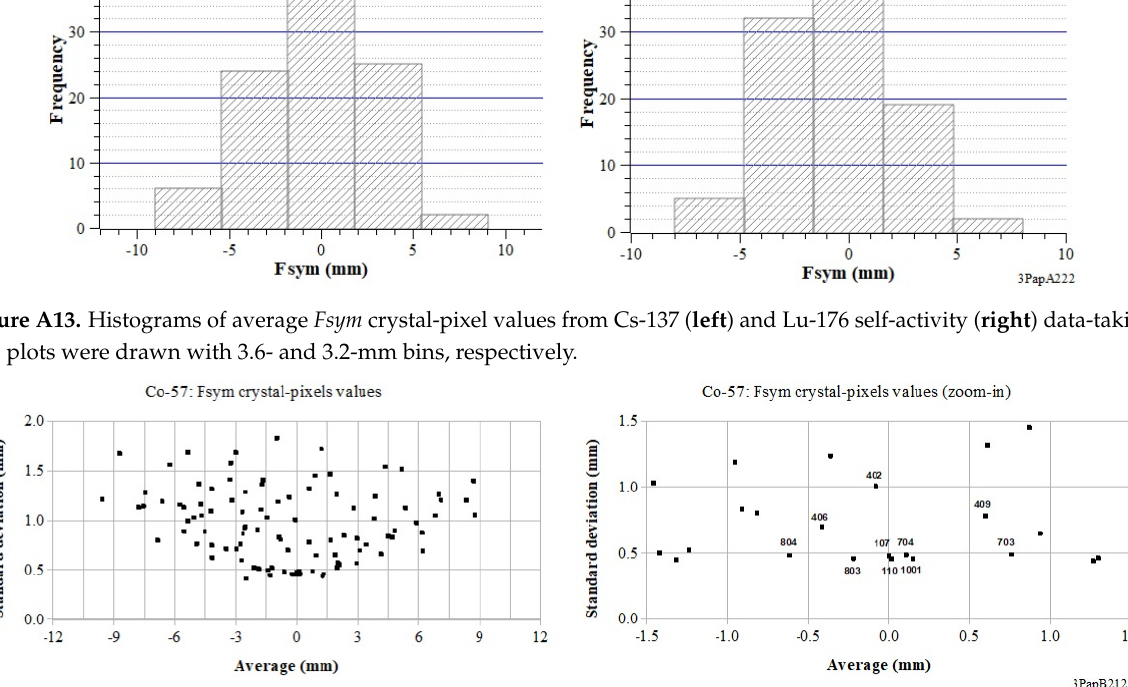
Figure A14. Plot of standard deviation Vs. average of Fsym values ( left ) obtained for all the crystal-pixels of the 10 × 10 array under Co-57 irradiation. A relevant overall dispersion of results is shown, suggesting to search for a subset of pixels showing the most similar symmetry properties. Zoom-in ( right ) of the central-zone of the plot on the left, showing the decuple of pixels with the smaller charge-spread values around the origin. The selected decuple was, in RRCC ascending order, 107, 110, 402, 406, 409, 703, 704, 803, 804, and 1001 with distance-values from origin ranging from 0.45- to 1.01-mm.